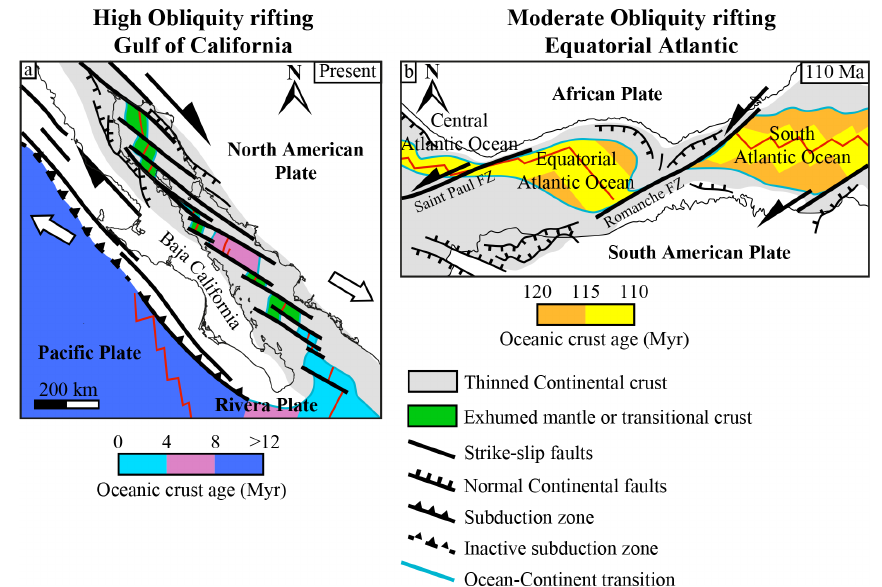
Figure 1. (a) Simplified structural map of the Gulf of California rift system (modified from Bonini et al., 2019; Ferrari et al., 2018; Fletcher et al., 2007). Large white arrows display the plate motion between the North American Plate and the Pacific Plate from Plattner et al., (2007). (b) Simplified structural map of the equatorial Atlantic rift system at 110Ma modified from Heine et al. (2013). FZ: fault zone. Half-headed black arrows represent the shearing